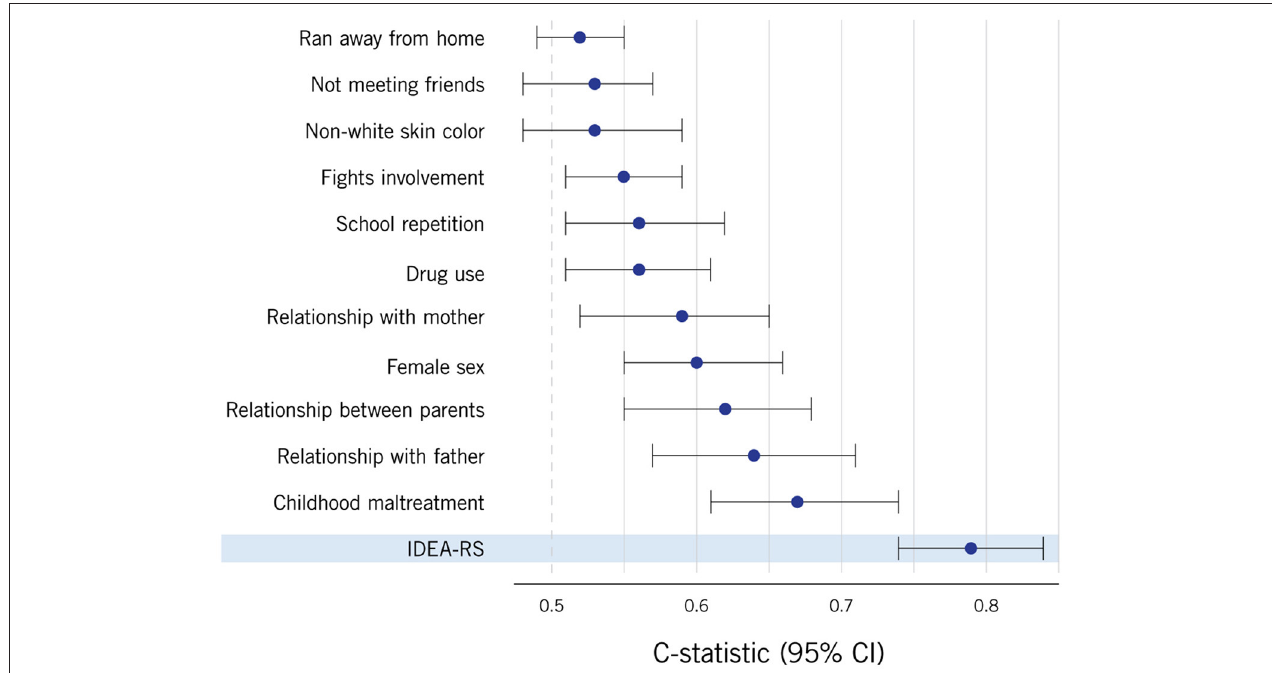
FIGURE 1 | Discriminative ability of each individual Identifying Depression Early in Adolescence Risk Score (IDEA-RS) variable, as well as the combined statistic for the IDEA-RS in the last line. Generated using data from the Pelotas 1993 Birth Cohort